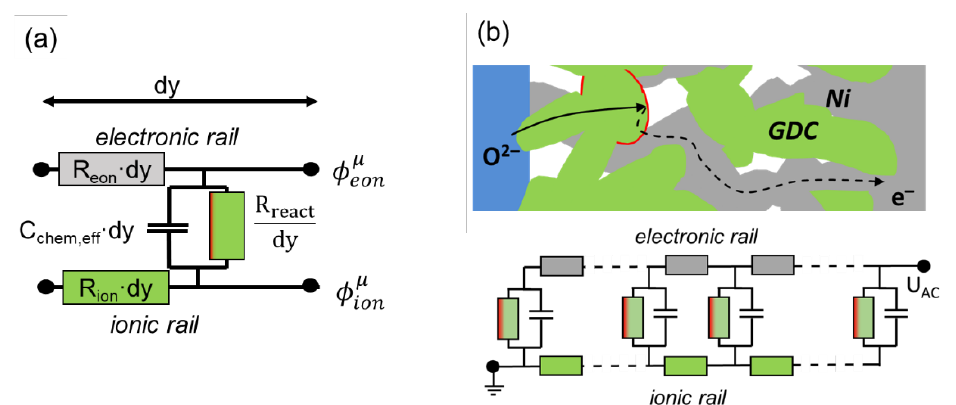
Figure 2. ( a ) Equivalent circuit model of an infinitesimally thin slice of the electrode (thickness dy) and ( b ) transmission-line-type equivalent circuit representing the differential equations for charge transport and electrochemical reactions in porous electrodes.